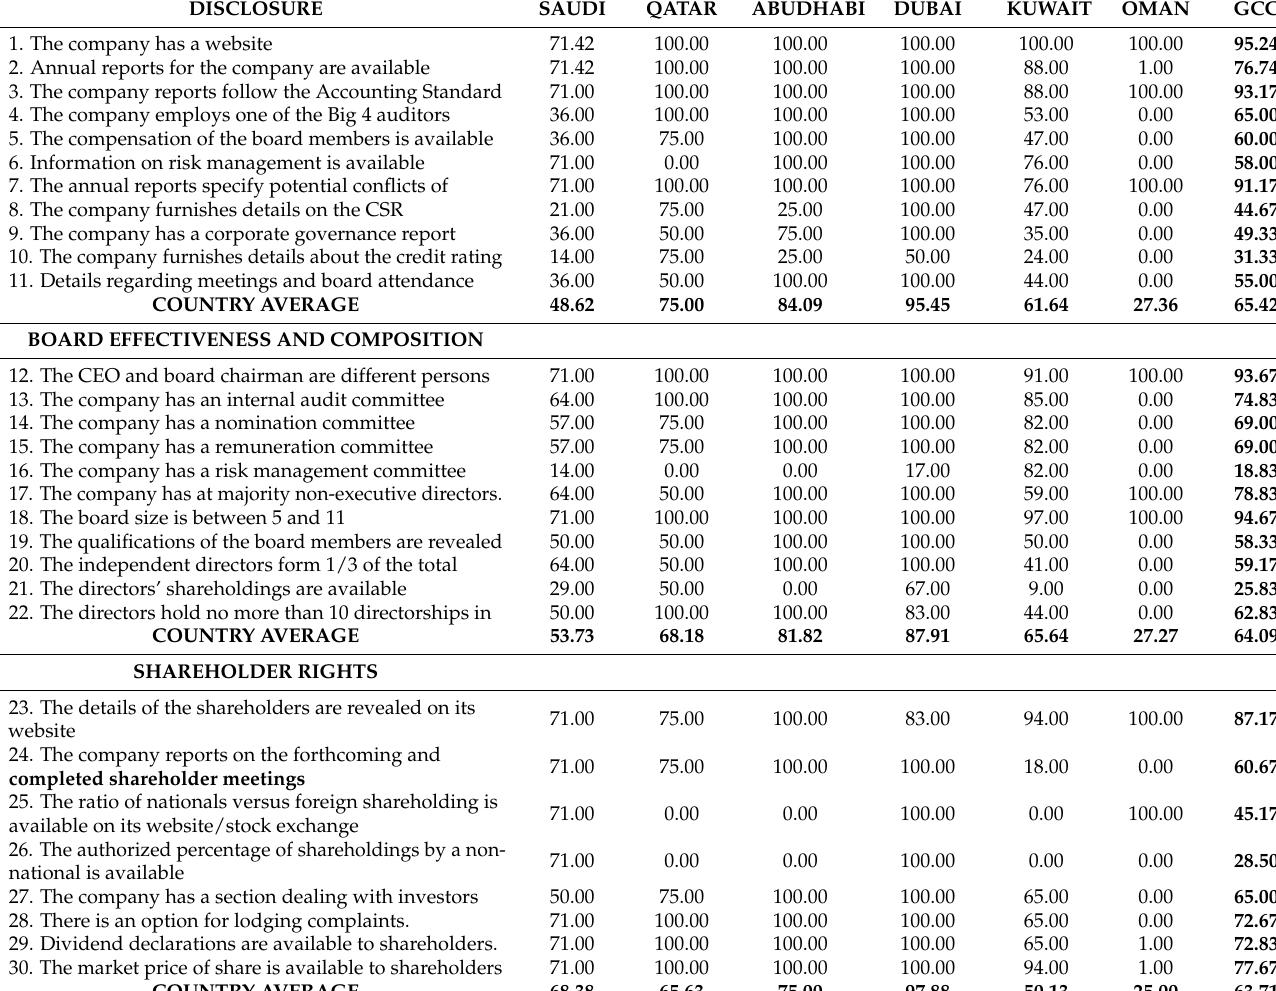
Table 2. Frequency of adherence to corporate governance